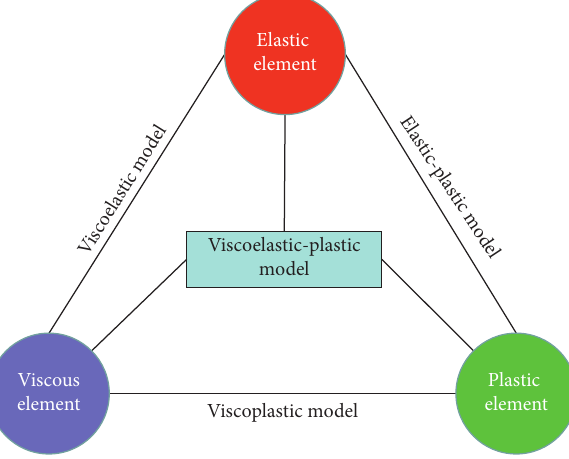
Figure 9: Combination forms of basic